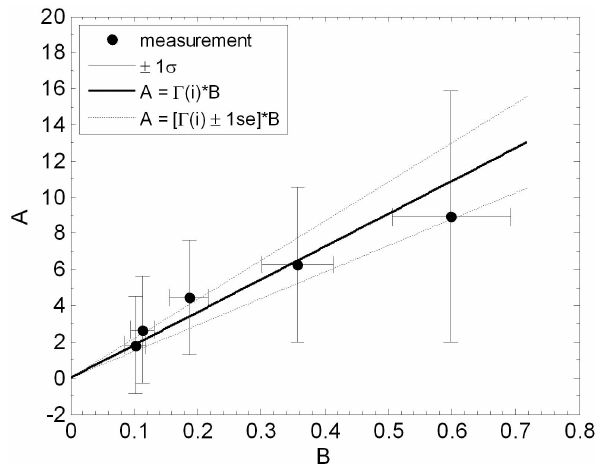
Fig. A1. Comparison of A and B calculated at 5.4nm geometric di- ameter with a least-squares fit line over the time period 12:40–13:00 during an NPF event observed on 19 September 2010 in Boulder, CO (NCAR). A relative uncertainty of 10% was assumed for the sulfuric acid concentration measurements when calculating B and its corresponding uncertainty. Median values of [H 2 SO 4 ] were used in this particular calculation (no systematic uncertainty applied). Uncertainties in A and B are presented as one standard deviation (1 σ) . The uncertainty in the best-fit value of 0 is presented as one standard error (1se) calculated according to Cantrell